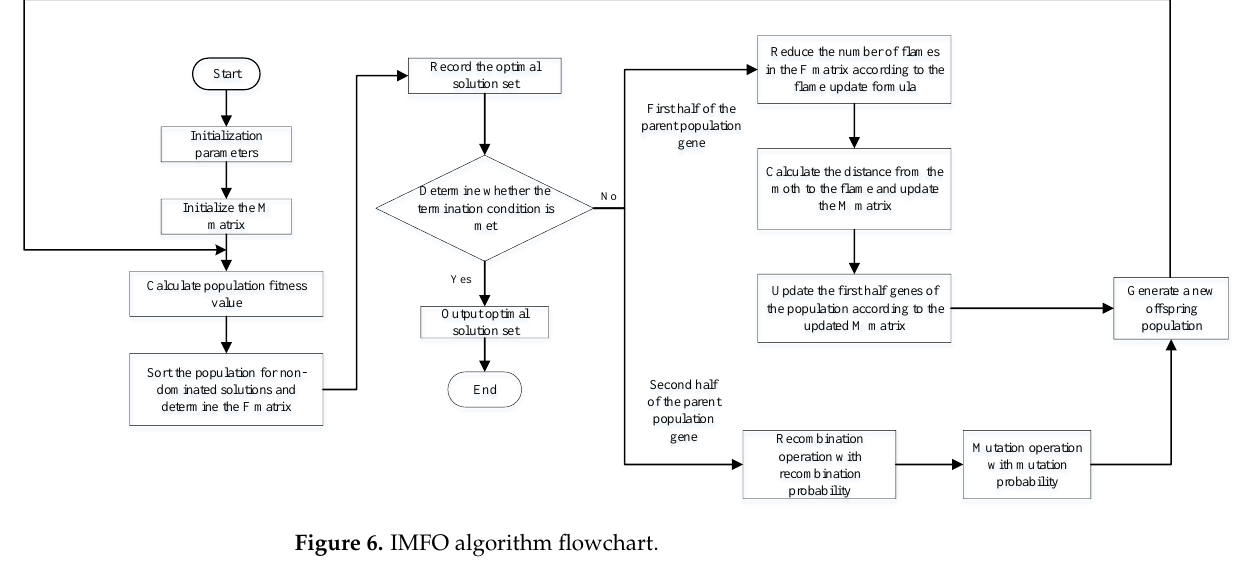
Figure 6. IMFO algorithm flowchart.